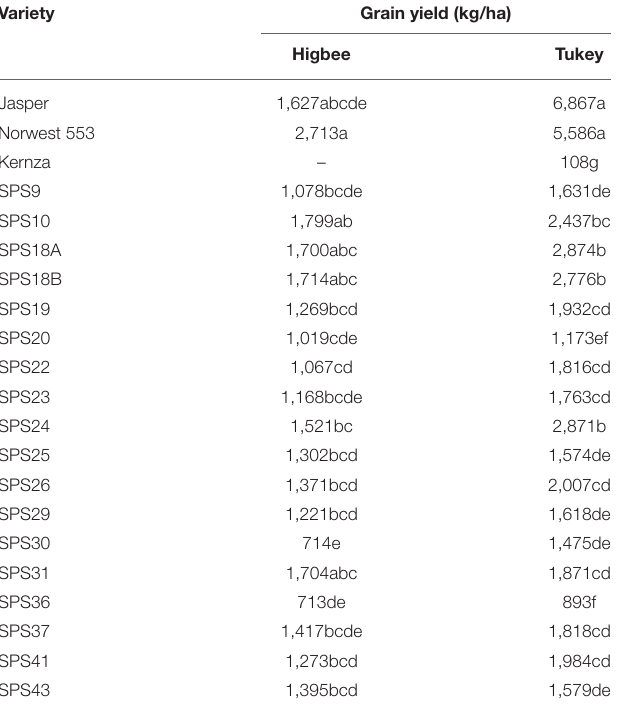
TABLE 7 | Mean yields at Higbee and Tukey locations in kilograms per hectare (kg/ha). Variety